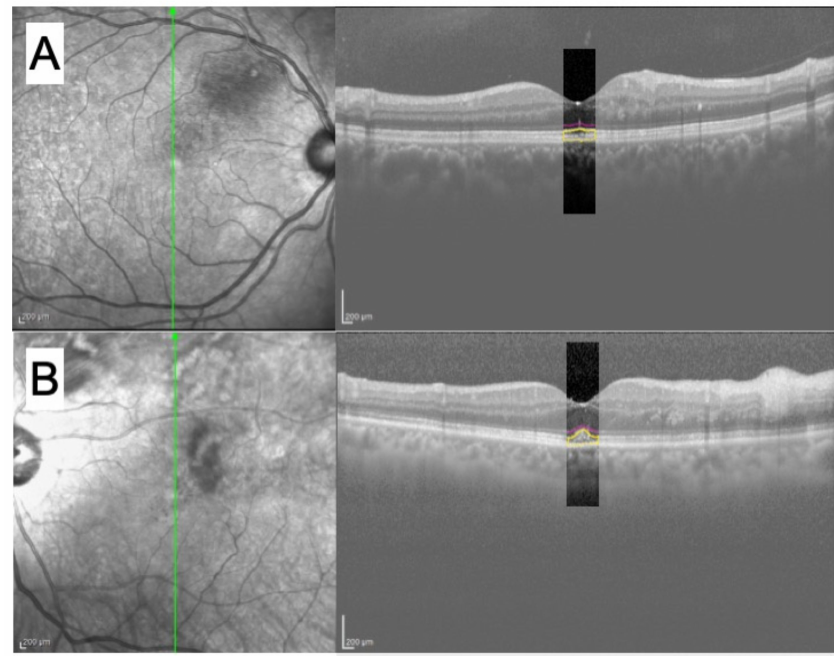
Figure 1. ( A , B ) SLO and OCT images of a representative case of branch retinal vein occlusion (BRVO) classified as Groups A and B, respectively, at the time of ME resolution. Each green line represents a scanned line in the fundus. OCT image on the right is a trimmed image of the original image. In the trimmed image, the ELM (pink) and EZ (yellow) lines are annotated, and the area surrounded by the EZ and RPE (yellow) lines. ELM = external limiting membrane; EZ = elliptical zone; RPE = retinal pigment